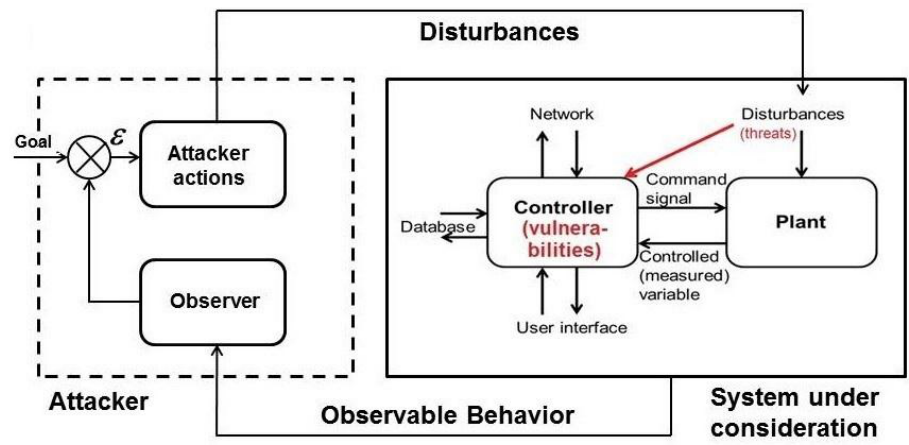
Figure 6. Modern cyberphysical system: disturbances and attacks.